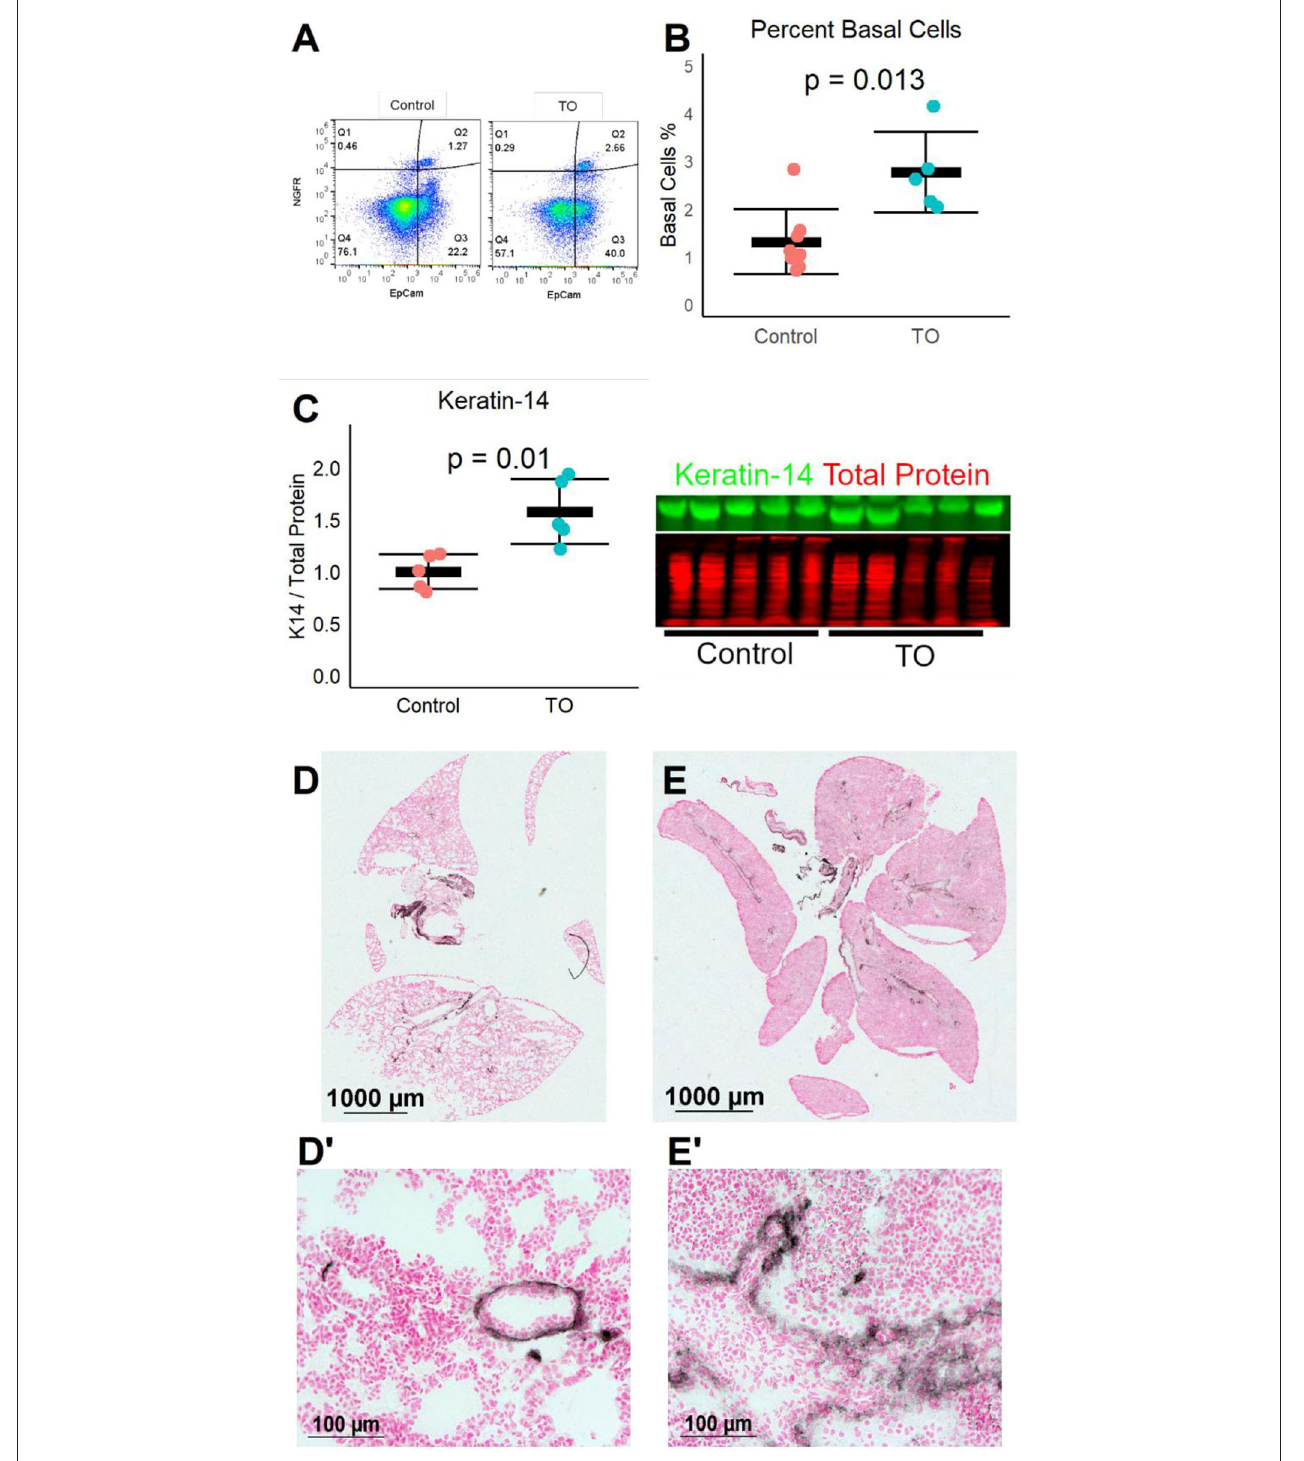
FIGURE 2 | Fetal endoscopic tracheal occlusion (FETO) increases the number and distalization of lung basal cells. (A) The percentage of lung basal cells as defined by the co-expression of EpCam and NGFR increased from ∼ 1.5 to ∼ 2.5% at E18.5 following tracheal occlusion (TO) at E16.5. (B) The increased percentage of basal cells in TO ( n = 6) compared to control ( n = 7) was consistent and statistically significant. (C) The whole-lung protein content of the basal cell marker keratin-14 was also increased ( n = 5 per group). (D) Immunohistochemistry of control lung for NGFR showed restriction of basal cells to the basement membrane of large conducting airways. (E) FETO lungs had increased cellularity and had extension of basal cells beyond the central conducting airways into the more distal conducting airways. (D ′ ) , Magnified Image of D; (E ′ ) , Magnified Image of E.